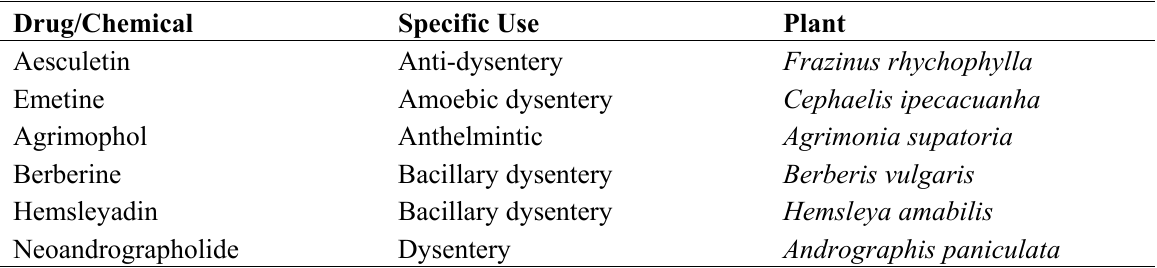
Table 3. Pharmaceutical products derived from indigenous medicinal plants used in the control of dysentery or diarrhoea-like